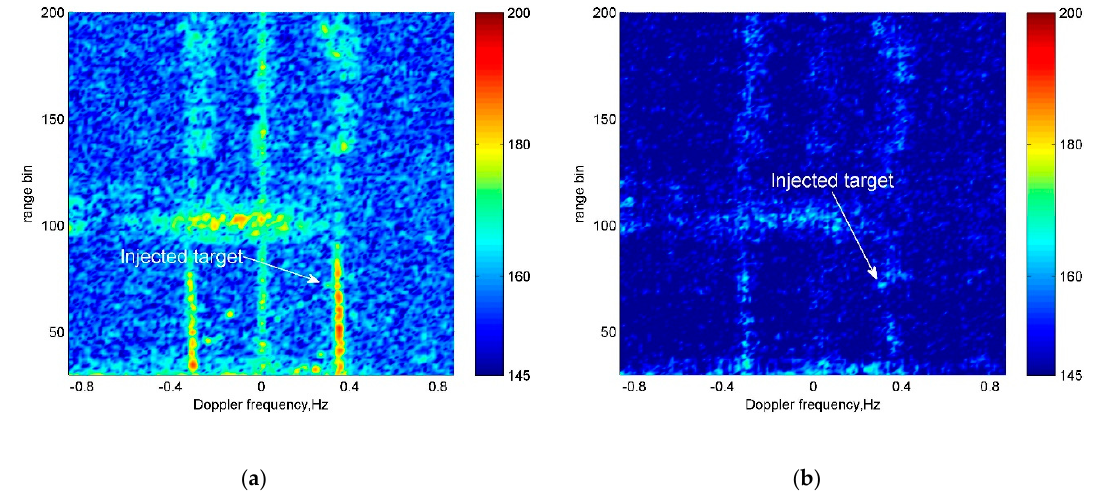
Figure 6. Experimental results using measured data with simulated target, ( a ) Range-Doppler map of DBF method, ( b ) Range-Doppler map of LE-JDL method.